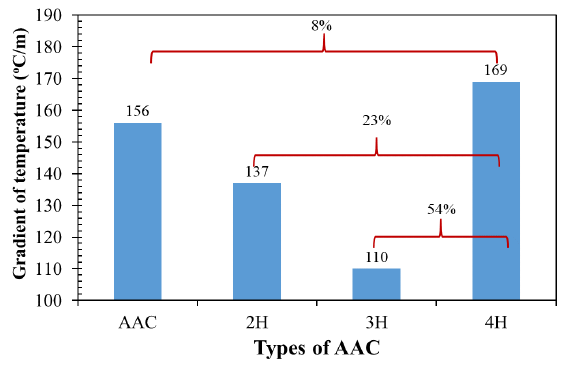
Figure 13. Comparison of gradient temperature of the 4 testing rooms.